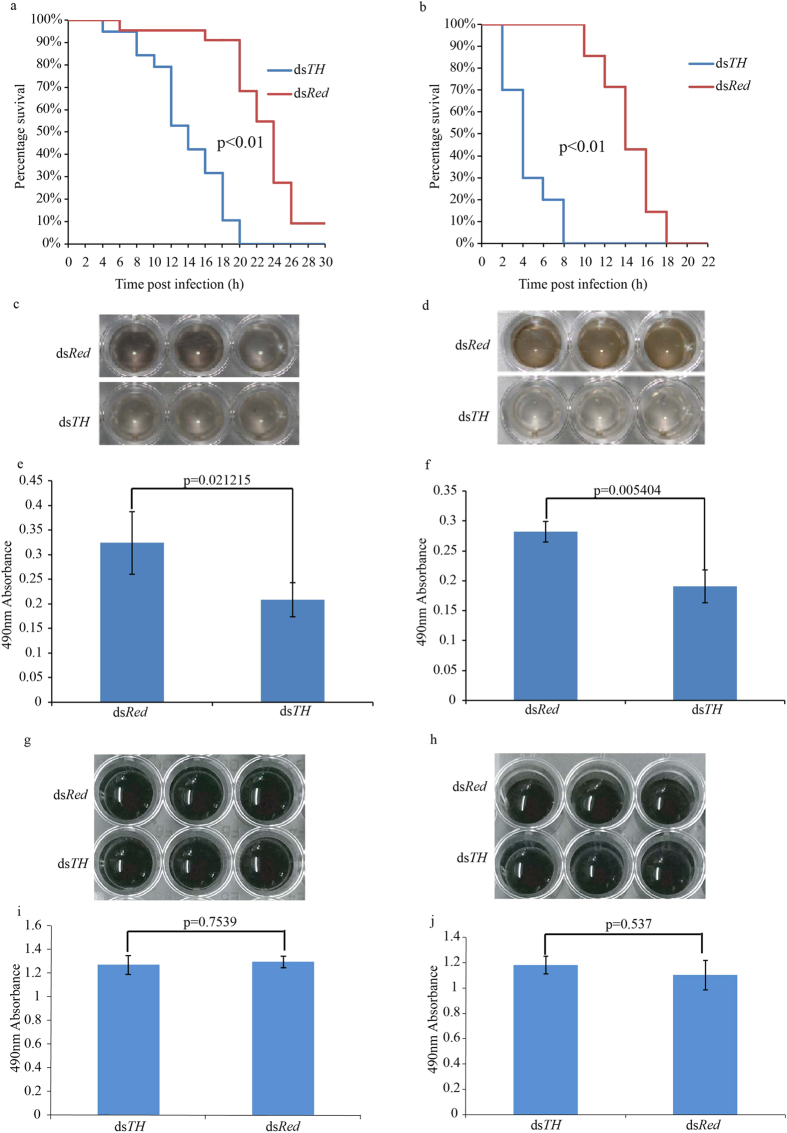
Effects of silencing the expression of AsTH on pupal resistance to exogenous microorganism infections.(a) and (b) indicate survival curves of dsTH and dsRed individuals subjected to Bacillus bombyseptieus and Serratia marcescens treatment, respectively (log rank test, p < 0.01). (c) and (d) present the degree of sample melanism of in vivo melanization after 1 h reaction. The degree of melanism in body fluid in dsRed group individuals is greater than that in dsTH individuals. (e) and (f) indicate the melanin amounts assessed from in vivo assay of dsTH and dsRed groups subjected to Bacillus bombyseptieus and Serratia marcescens treatment, respectively (t-test, n = 3, p < 0.01). (g) and (h) depict sample melanism of in vitro melanization after 1 h reaction. No obvious differences in the degree of melanism in body fluids between dsRed and dsTH groups are evident. (i) and (j) indicate melanin amounts assessed from in vitro assay of dsTH and dsRed individuals subjected to Bacillus bombyseptieus and Serratia marcescens treatment, respectively (t-test, n = 3, p > 0.5).